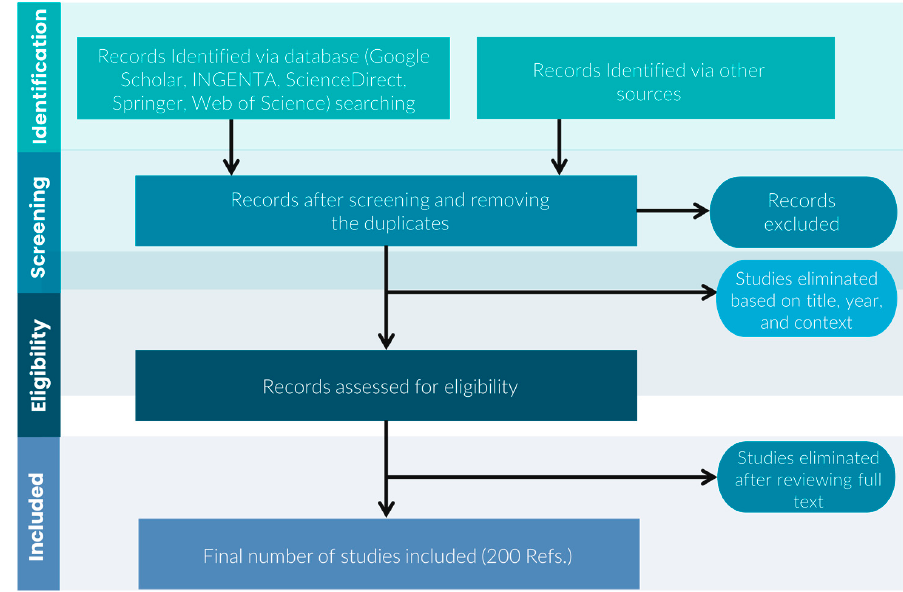
Materials 2023 , 16 , x FOR PEER REVIEW Figure 1. A schematic fl owchart of the strategy used to prepare the current review. Figure 1. A schematic flowchart of the strategy used to prepare the current review.